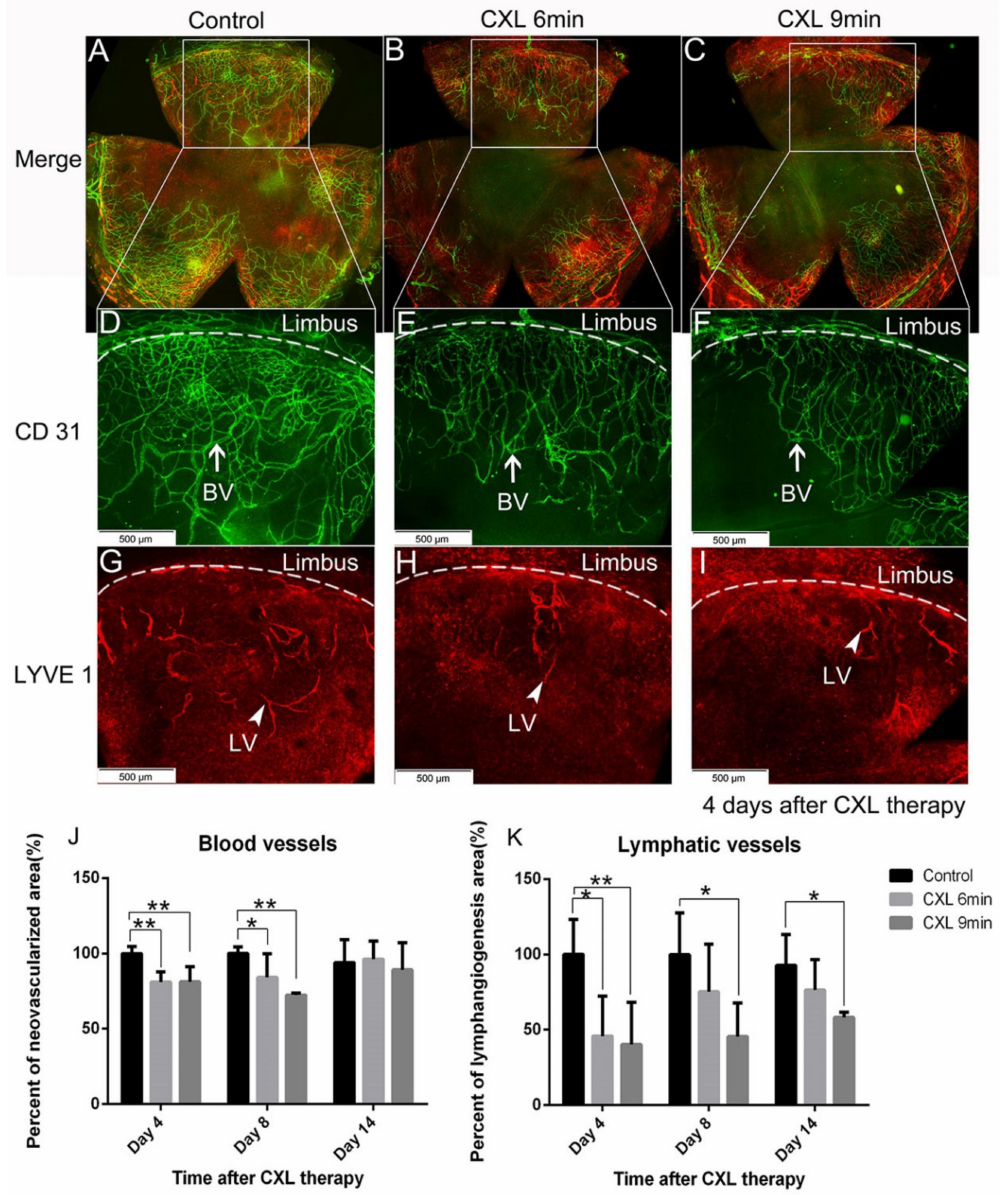
Figure 4. Regression of mature corneal blood (BV) and even more so lymphatic vessels (LV) after UV-A-light based corneal collagen crosslinking (CXL). Corneal whole mount staining after induction of inflammatory corneal neovascularization was performed to quantify both corneal blood and lymphatic vessels via immunohistochemistry. Corneal vessels were double stained 4 days after CXL treatment (( A – C ): merged images). Blood vessels were stained with FITC-conjugated CD31 (( D – F ): BV with white arrow in green) and lymphatic vessels were stained with lymphatic vessel endothelial hyaluronan receptor 1 (LYVE-1) followed by Cy3-conjugated secondary antibody (( G – I ): LV with white arrowhead in red) (magnification: × 100; scale bar: 500 µ m). Corneal lymphatic vessels in the 6-min CXL-treated group showed a significant reduction on day 4 post CXL but not on day 8, while in the 9-min CXL-treated group, lymphatic vessels were regressed significantly on both day 4 and day 8 after treatment ( K ) ( n = 5; * p < 0.05, ** p < 0.01). At 14 days after CXL treatment, corneal lymphatic vessels in the 9-min CXL-treated group were still significantly reduced compared with the control group, while there was no significant difference in the 6-min CXL-treated group ( K ). Mature corneal blood vessels were regressed significantly on day 4 and day 8 after a 6-min or 9-min CXL treatment ( J ). ( n = 5; * p < 0.05). Reproduced from Hou et al. 2018